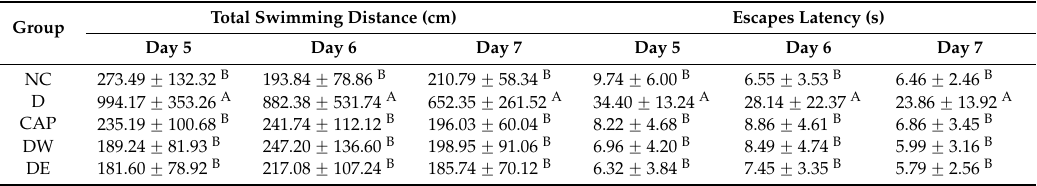
Table 5. Effects of administration of the extracts from TWK10-fermented soymilk on working memory task in Morris water maze in DOCA-salt induced hypertension and its associated dementia rats. Total Swimming Distance (cm) Escapes Latency Group